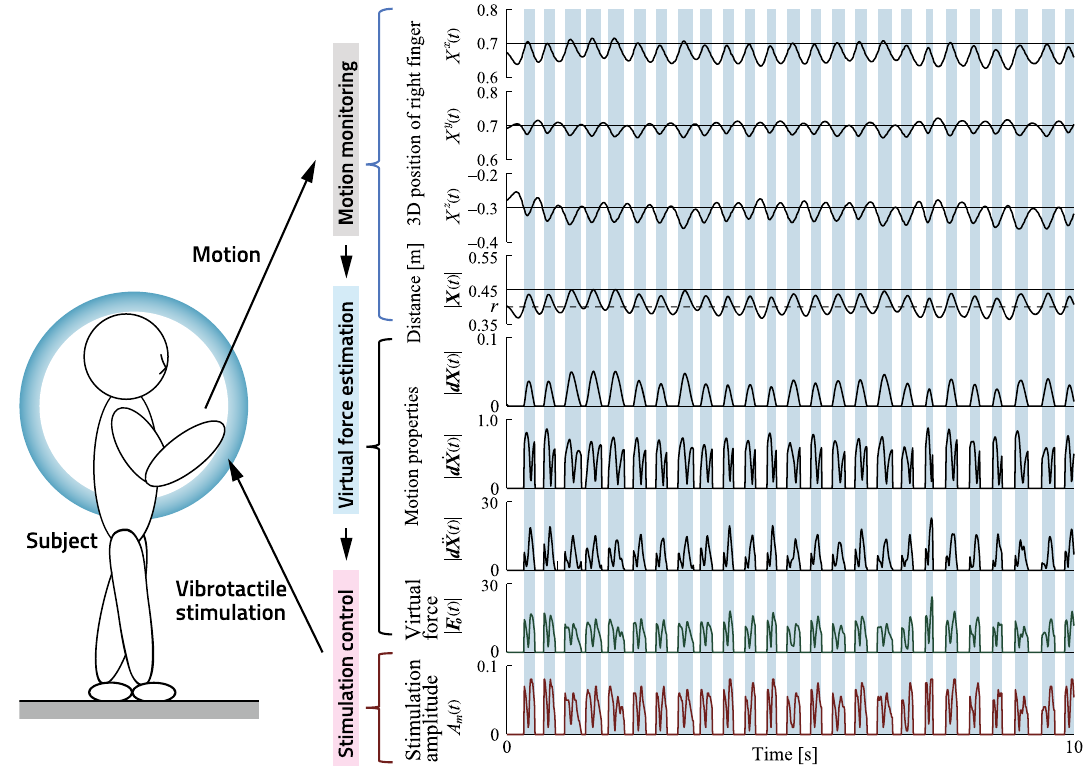
Figure 2. Experimental results for VLT conditions. Top to bottom: 3D finger position, norms of trunk-fingertip distance, motion properties (norm of distance into the partition, velocity and acceleration), estimated virtual force, system-generated stimulation amplitude. Usage is also shown in Movie